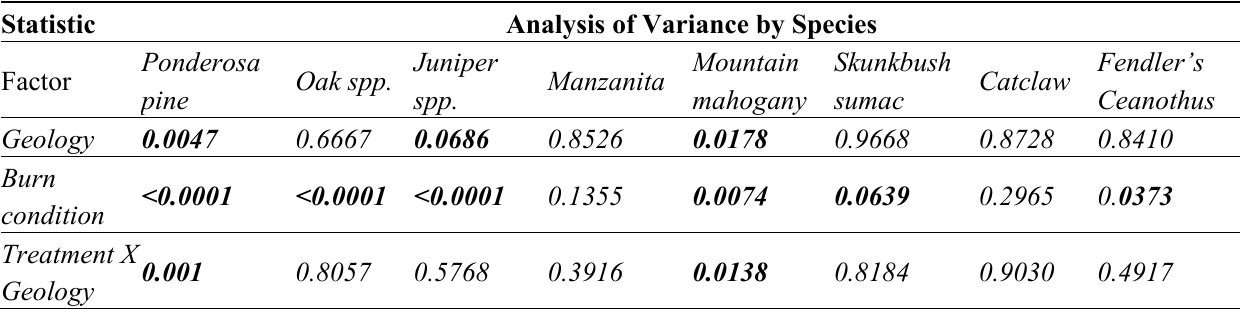
Table 2. p -values for two-way analysis of variance tests comparing the effects of fire on woody plant density. Bold numbers indicate significance at α = 0.10.